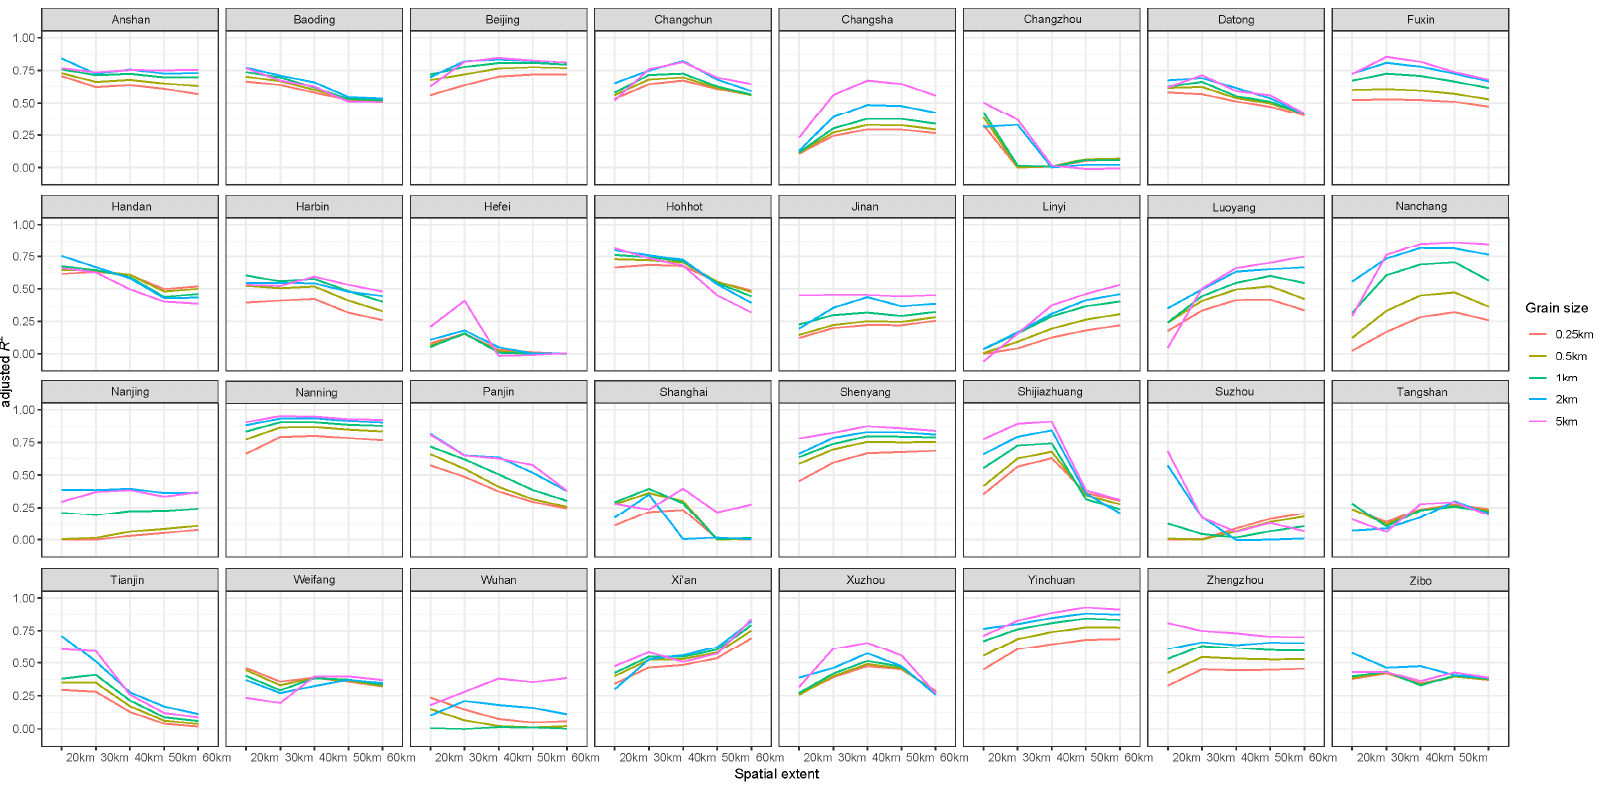
Figure A9. Explanatory power of NDVI for explaning LST(Scalogram of the spatial extent)